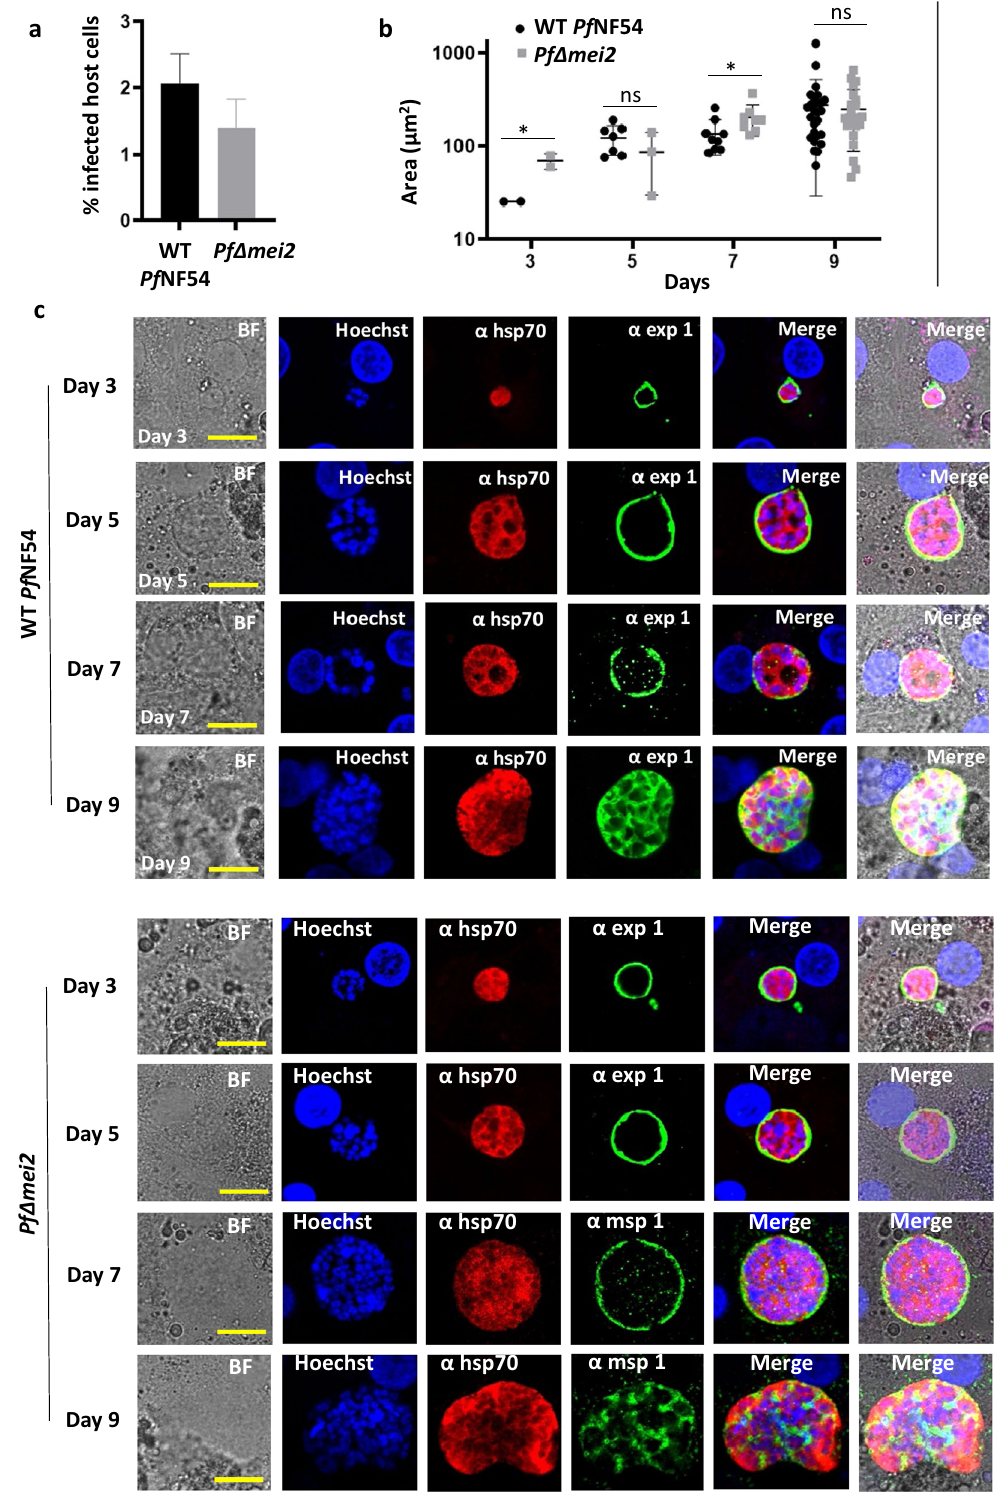
Fig. 2 Pf Δ mei2 liver-stage development in cultured human primary hepatocytes (BioIVT). a Percentage of hepatocytes infected with WT Pf NF54 and Pf Δ mei2 at day 3 post infection (p.i.) ( p = 0.002; unpaired Mann – Whitney test). b Liver-stage size on day 3, 5, 7, and 9 p.i. (3-20 parasites measured in two wells). The average of the parasite ’ s cytoplasm at its greatest circumference using HSP70-positive area ( μ m 2 ), s.d. and signi fi cances values are shown (unpaired Mann – Whitney test: * p < 0.05; ns: not signi fi cant). c Representative confocal microscopy images of liver stages on days 3, 5, 7, and 9 p.i. Upper panel WT Pf NF54; lower panel Pf Δ mei2. Fixed hepatocytes were stained with the following antibodies: rabbit anti- Pf HSP70 ( α hsp70), mouse anti- Pf EXP1 ( α exp1), and anti- Pf MSP1 ( α msp1). Nuclei stained with Hoechst-33342. All pictures were recorded with standardized exposure/gain times; Alexa Fluor ® 488 (green) 0.7 s; anti-IgG Alexa Fluor ® 594 (red) 0.6 s; Hoechst (blue) 0.136 s; bright fi eld (BF) 0.62 s (1× gain). Scale bar, 10 μ m. Error bars represent standard